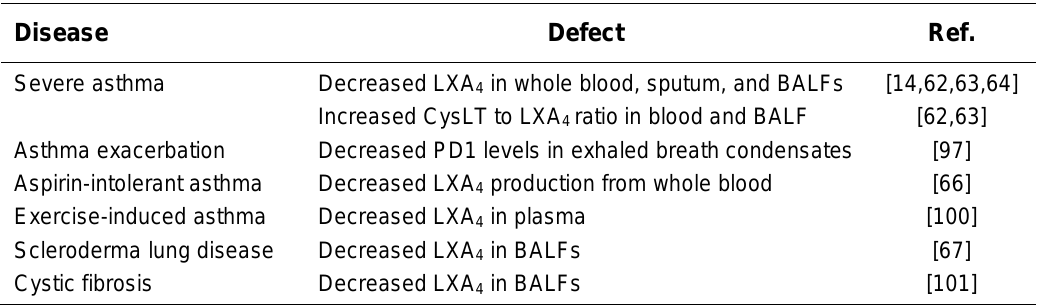
Altered Biosynthesis of Proresolving Mediators in Human Disease